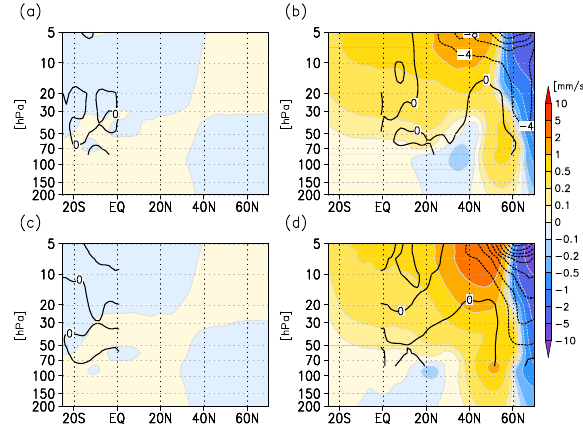
Fig. 7. (Top) Anomalies of the EP flux divergence (contours; ms − 1 d − 1 ) and of the generated residual mean vertical wind us- ing the EP flux divergence above 80hPa (color shading; mms − 1 ) on 18 January 2009: (a) forcing in the southern hemispheric strato- sphere and (b) northern hemispheric stratosphere. (Bottom) (c) and (d) : same as (a) and (b) except for F (z) component only. These 1 anomalies are the deviation from the mean value for January 2009. Contour interval is 4ms − 1 d − 1 . Divergences of the EP flux and F (z) below 90hPa are not shown. See Table 1 for 1